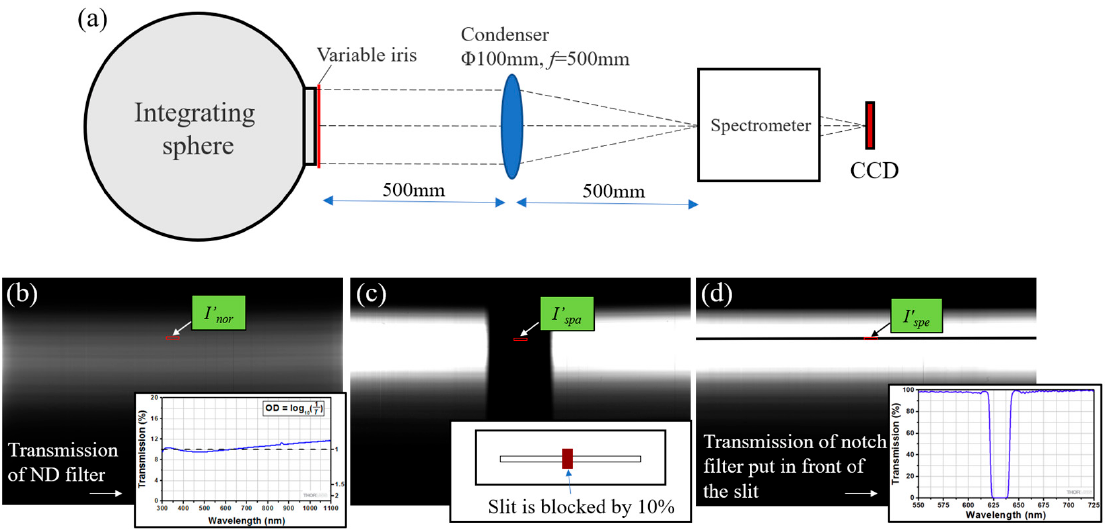
Figure 20. Test of stray light. ( a ) Schematic diagram of the test device, ( b ) the image of the spectrometer when a ND filter is put in front of the slit, ( c ) spatial stray light tested by black spot method, ( d ) spectral stray light tested using the notch wave method.